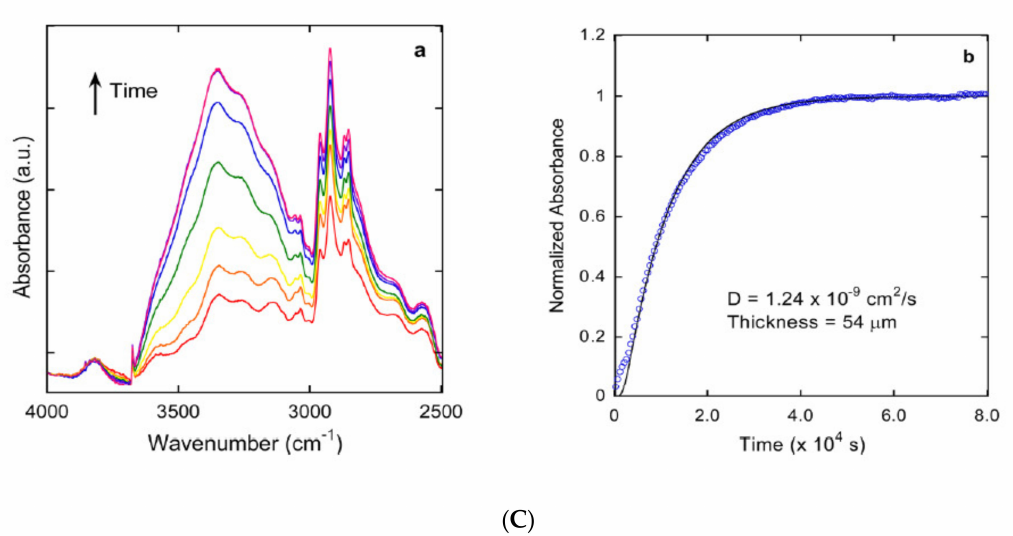
Figure 7. Time-resolved infrared spectroscopy data: normalised integrated absorbance of the water O − H stretching region in polymer–poly(isobutylene)–PIB, poly(methyl methacrylate)–PMMA and a crosslinked polymer–epoxy/amine resin at room temperature for solution-cast film and free-standing film in ( A – C ), respectively (used with copyright permission) [41]. ( A ) Time-resolved infrared spectroscopy data: normalised integrated absorbance of the water O − H stretching region in PIB at room temperature for the (a) solution-cast film and (b) free-standing film. The solid line represents a regression to the ATR solution of the Fickian model. ( B ) Time-resolved infrared spectroscopy data: normalised integrated absorbance of the water O − H stretching region in PMMA at room temperature for (a) solution-cast film and (b) free-standing film. The solid line represents a regression to the ATR solution of the Fickian model. ( C ) Time-resolved infrared spectroscopy data: (a) infrared spectra of the water O − H stretching region, showing water diffusion in an epoxy/amine coating free-standing film, and (b) normalised integrated absorbance of the water O − H stretching region. The solid line represents a regression to the Fickian